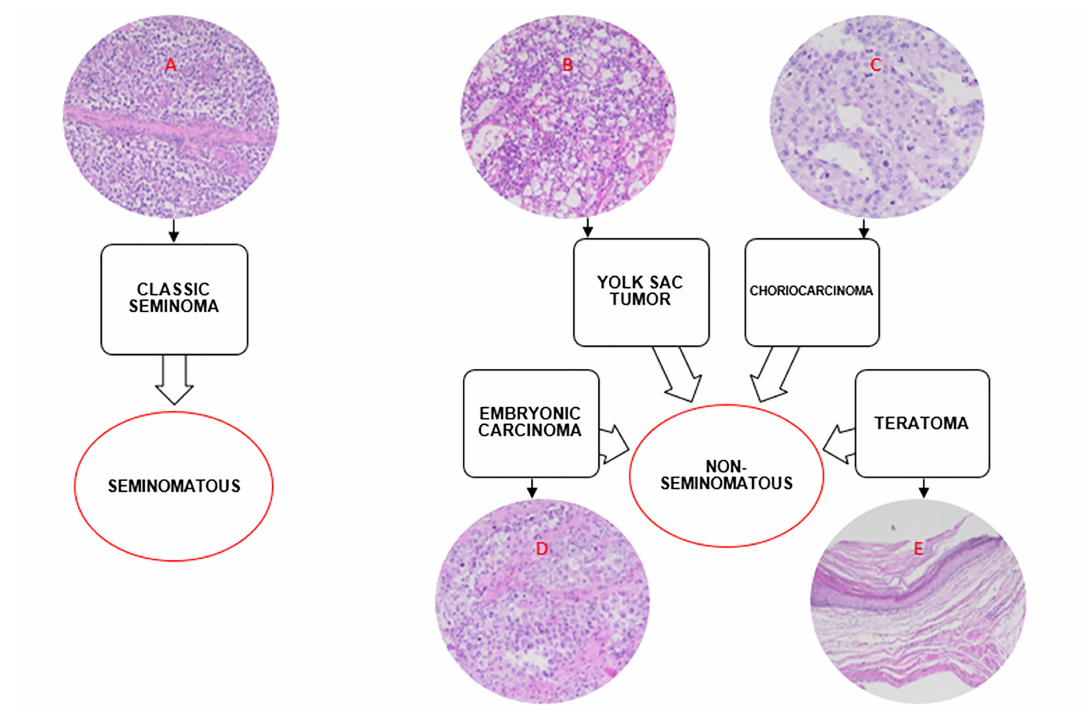
Figure 2 - Seminoma and non-seminoma tumors subtypes and their histological representations. The histological representation was prepared by hematoxylin and eosin (HE) method. The analysis was done under 200x magnification and the images were provided by the Department of Pathology of the São Paulo Federal